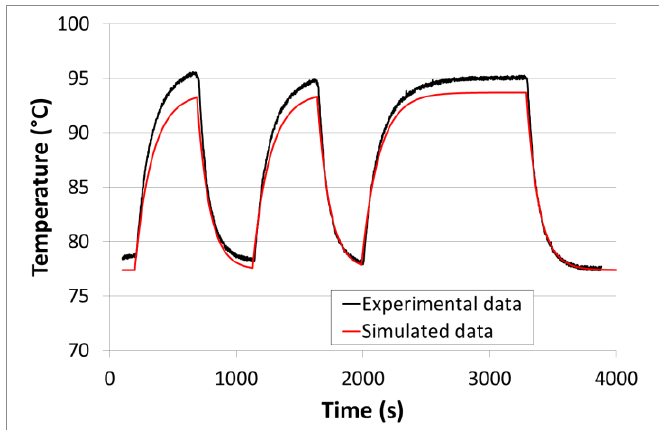
Figure 4. Experimental and simulated temperature behavior of the first WiPirani demonstrator submitted to pressure cycles, at low pressure. The pressure was changed between two levels–100 Pa and 0.1 Pa–using an on/off valve. The pressure changed quickly between these two levels (the pressure equilibrium was reached in a few seconds